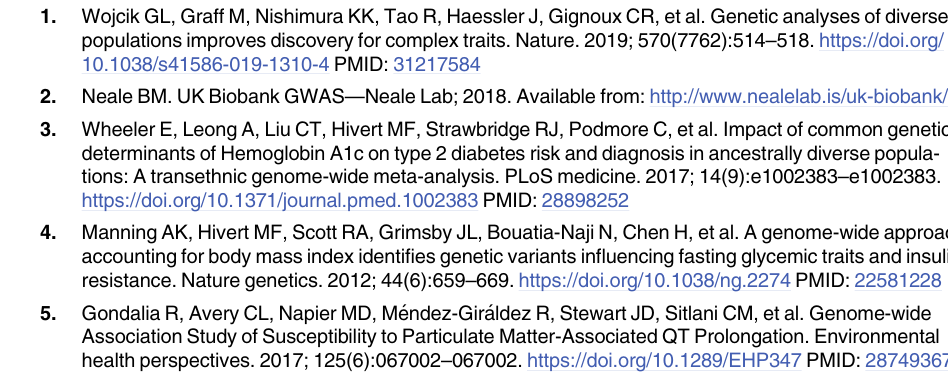
S8 Table. List of NHLBI TOPMed consortium